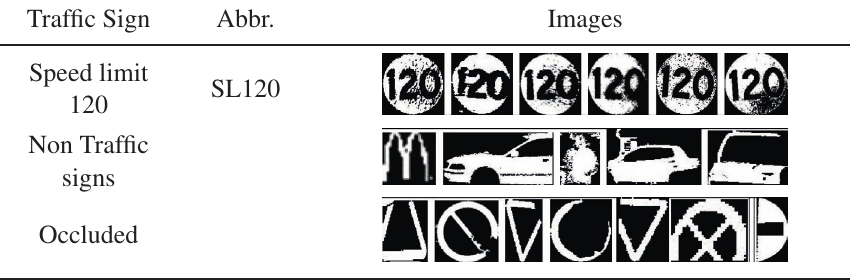
Table 1. Part of the training and testing